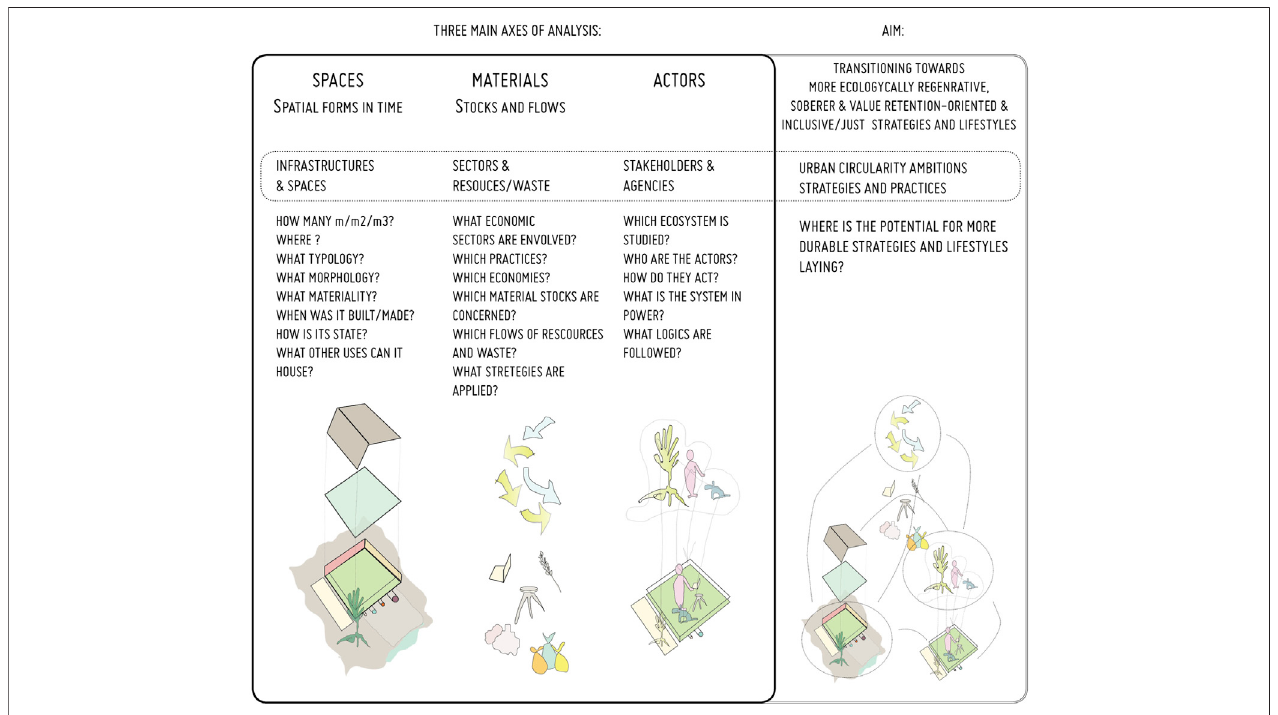
FIGURE 1 | Research framework: three tracks of analysis (spaces, materials, and actors) are identi fi ed, by the authors to enable a re fl ection across multiple disciplines and aspects on urban circularity practices (UCPs).